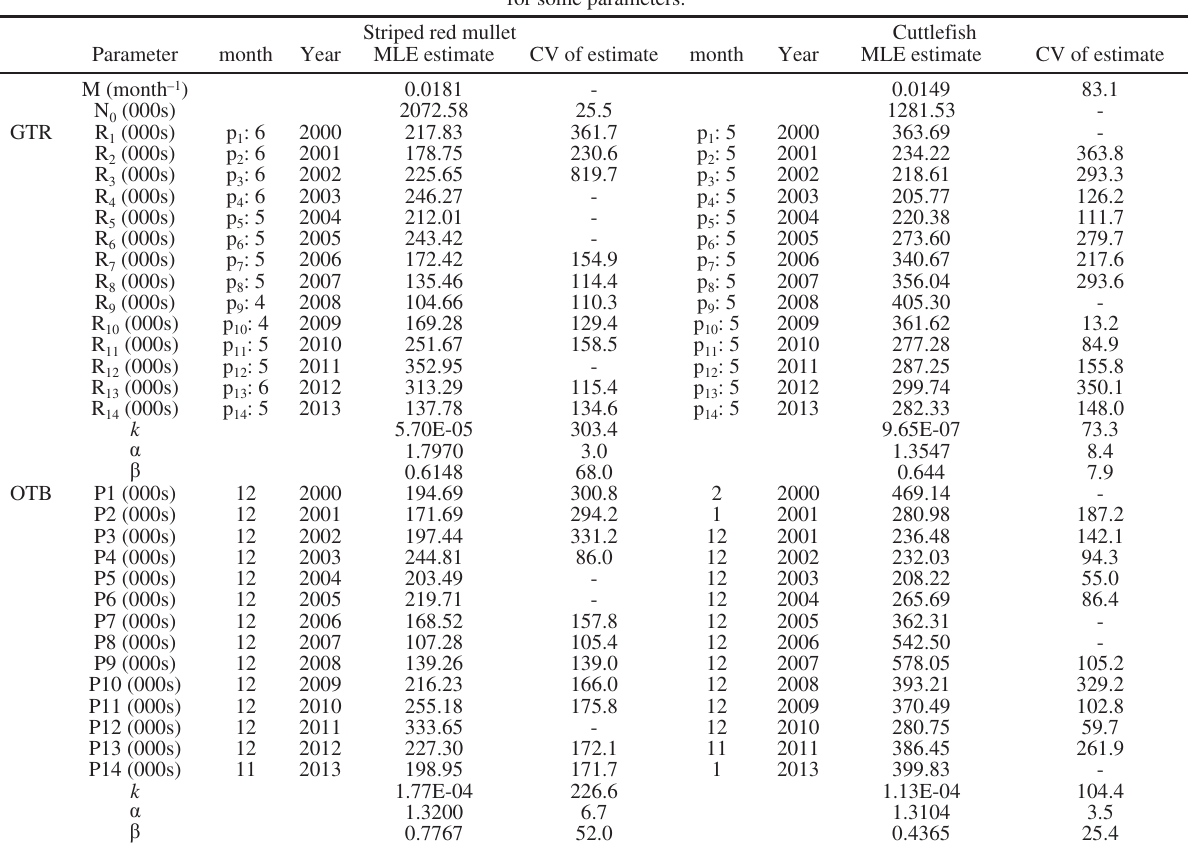
Table 2. – Results of the multi-annual generalized depletion model applied to the Vilanova trammelnet (GTR) and bottom trawl (OTB) fisher- ies for striped red mullet ( Mullus surmuletus ) and cuttlefish ( Sepia officinalis ) in the period 2000-2013. Results (MLE, maximum likelihood estimate; CV, coefficient of variation) shown are for the selected model, assuming lognormal distribution in the errors under CG (Conjugate Gradient optimization, cf. Table 1). N , number of individuals at the start of the period; p1 to p14, timing; R to R , magnitude of perturbation 0 1 14 (recruits); k : catchability parameter; a , catchability-effort parameter; b , abundance-CPUE parameter. Note that the CV could not be estimated for some